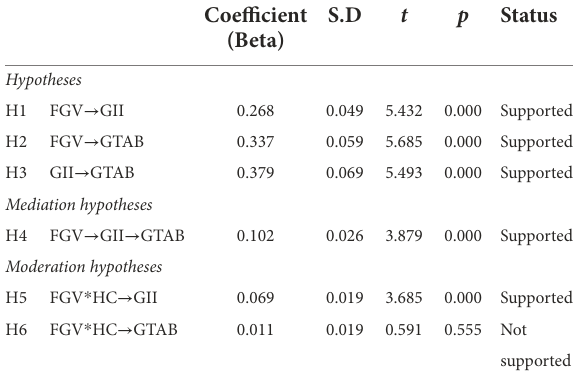
TABLE 3 Discriminant validity (HTMT).